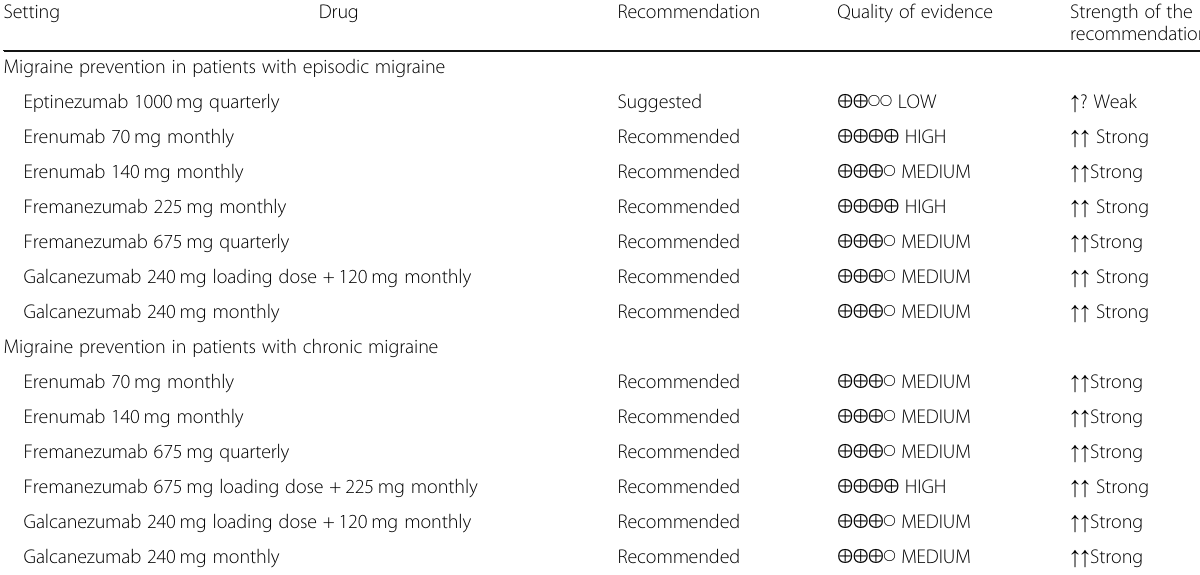
Symbols depict the strength of the recommendation according to the GRADE